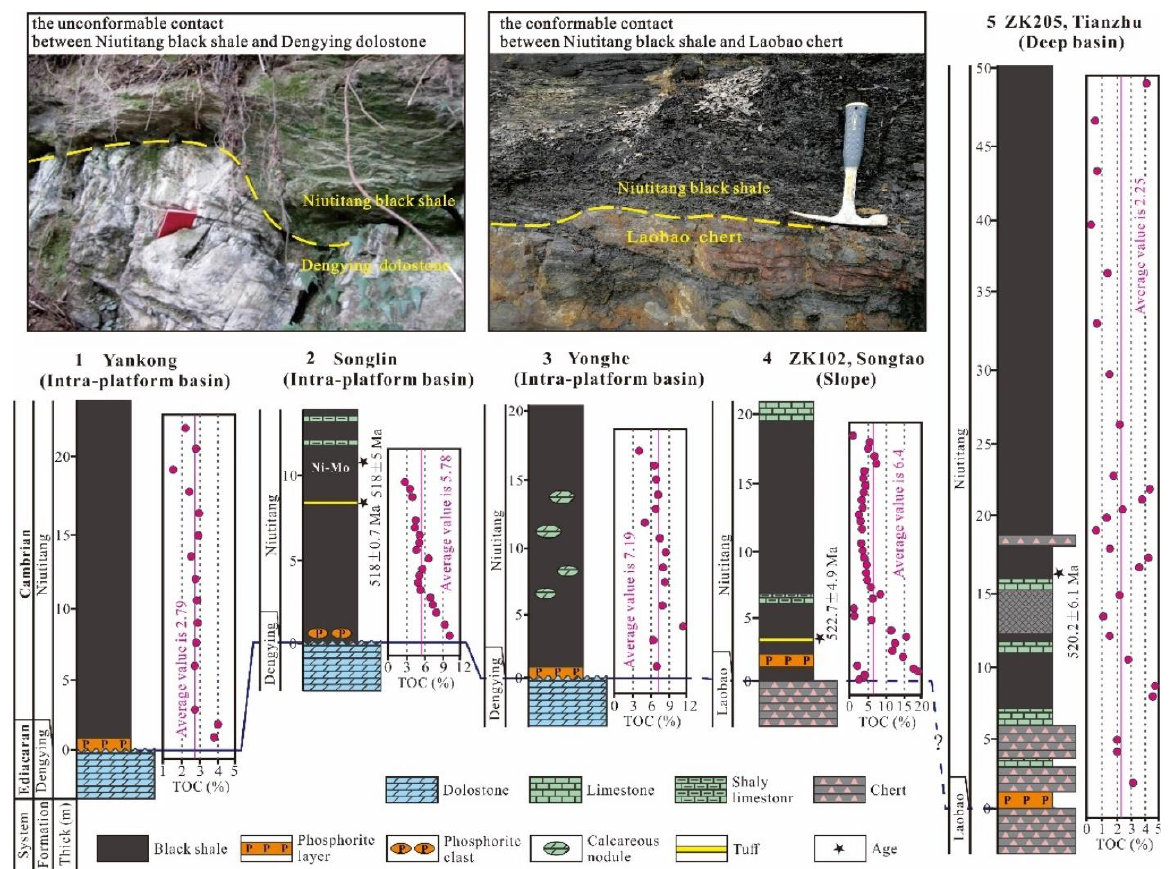
Figure 2. Contact relationship between the Ediacaran and Cambrian strata, and the stratigraphic columns and TOC contents of the Early Cambrian black shale. The ages are cited from [47 – 49].